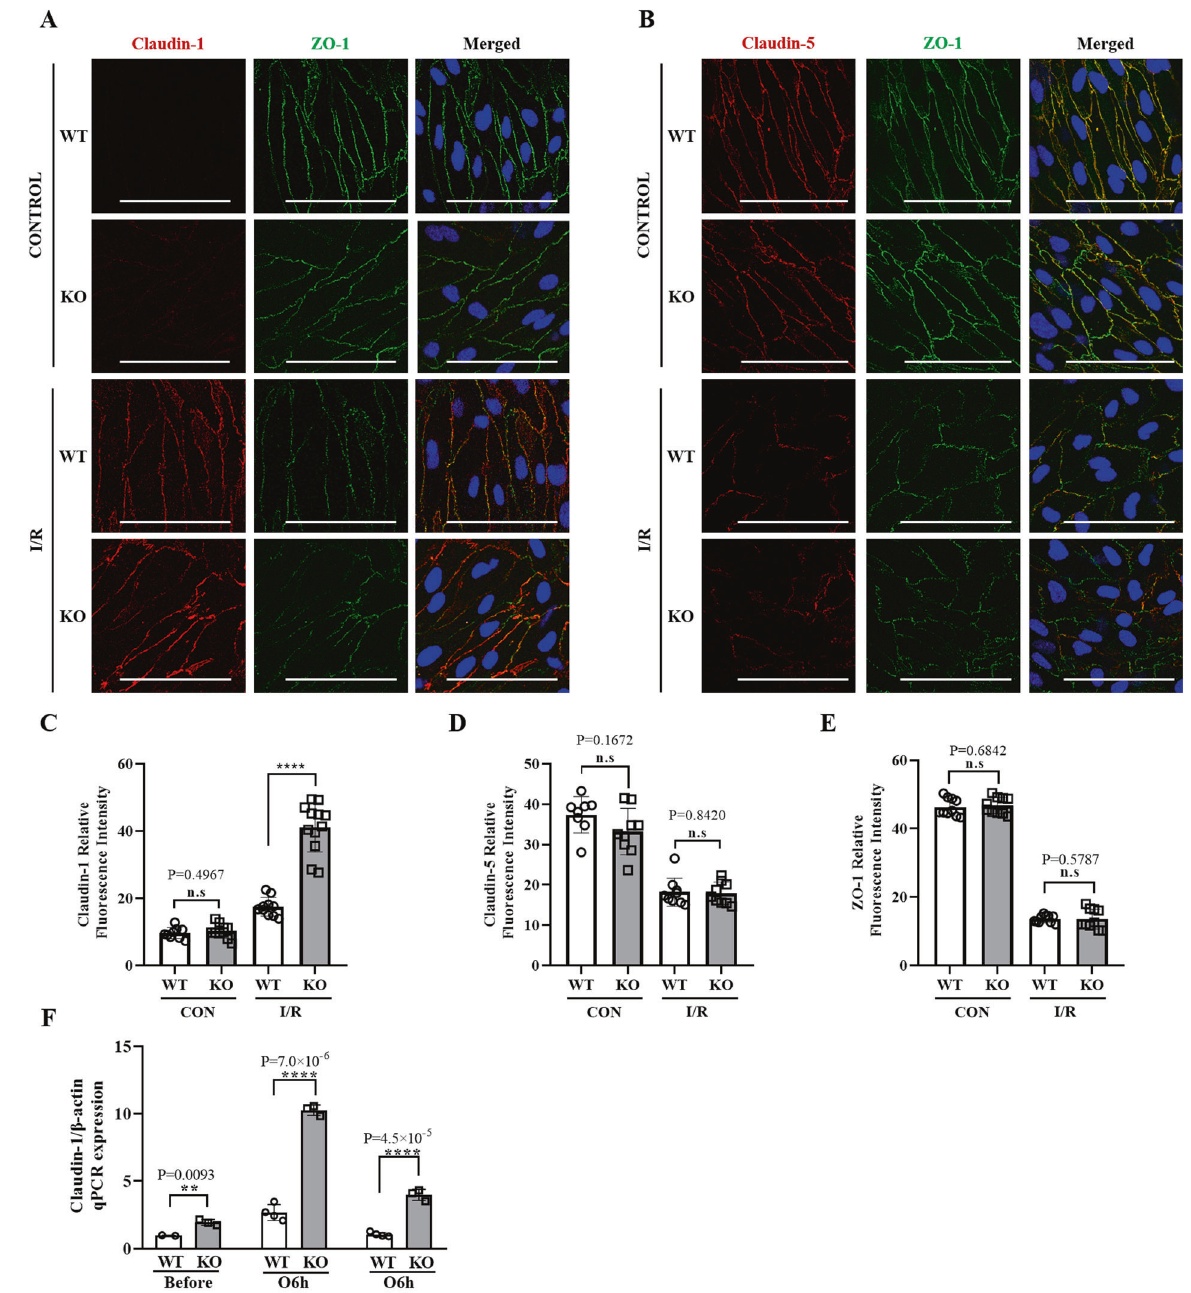
Fig. 6 CRTC1 de fi ciency enhances TJ proteins destabilization induced by ischemia/reperfusion in Mouse BMECs. Representative immunostaining images of Claudin-1/ZO-1 ( A ), Claudin-5/ZO-1 ( B ) and quanti fi cation of Claudin-1 ( C ), Claudin-5 ( D ), and ZO-1 ( E ) of BMECs derived from CRTC1 KO and WT, before and after ischemia/reperfusion (Scale Bar, 100 μ m). F qPCR results of Claudin-1 in BMECs derived from CRTC1 KO and WT mice, before and after ischemia/reperfusion. n = 4 for each group. compared to the vehicle group, suggesting that miR-132 following 3 h OGD, HUVEC co-cultured with neurons showed a upregulated ECs resistance to OGD by an external pathway. relatively lower expression of TJAP-1 (Fig. 7J) and Claudin-1 (Fig. HUVECs co-cultured with neurons that were transfected with 7K) than HUVECs cultured alone. To functionally test the paracrine antagomir showed hardly differences compared to the vehicle secretion of miR-132 from neuron, we transfected miR-132/212 group, which may because OGD/Reperfusion inducing ECs damage mimic/antagomir/vehicle into neurons which were co-cultured was already occurred that could be hardly exaggerated further- with HUVECs, then subjected the cultures to OGD following up to more (Fig. 7M). Taken together, these results indicate that CRTC1 48 h reperfusion (Fig. 7L). No signi fi cant differences were found affects BBB integrity by a paracrine pathway, suggesting that before OGD among these groups. After subjected to OGD/ CRTC1-mediated release of miR-132/212 from neurons impacts the Reperfusion, HUVECs co-cultured with neurons that were trans- functional integrity of vascular endothelial cells (Fig. 8). fected with miR-132 mimic gradually attenuated the TEER decline